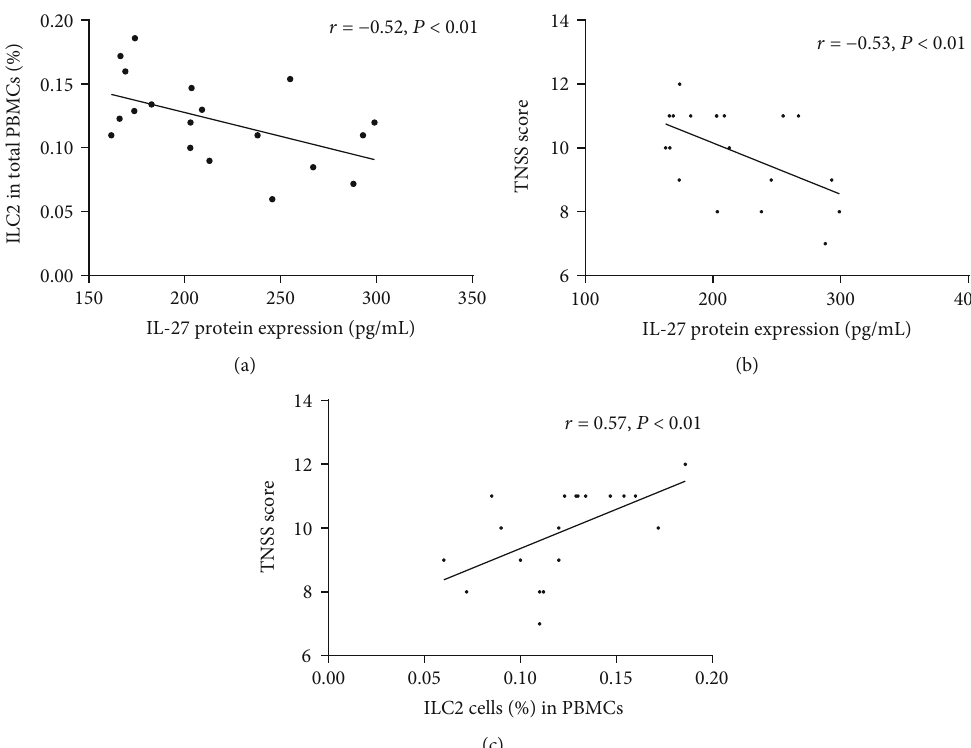
Figure 2: Correlation between of IL-27 protein expression, the proportion of ILC2 in PBMCs, and TNSS score in AR. (a, b) Correlation between IL-27 protein levels and ILC2 frequency and TNSS score. (c) Correlation between ILC2 frequency and TNSS score. AR: allergic rhinitis; ILC2: group II innate lymphoid cells; PBMC: peripheral blood mononuclear cells; TNSS: total nasal symptom score.